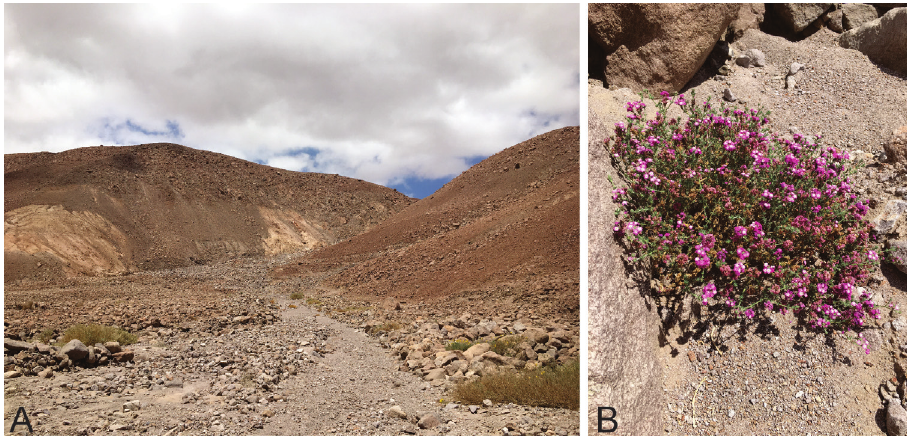
Figure 6. Habitat and host plant of Scrobipalpulopsis aguilaensis sp. nov. A habitat at the type locality, Cuesta el Águila, Cardones ravine, Arica Province, northern Chile B host plant, Glandularia gynobasis (Verbenaceae), at the type